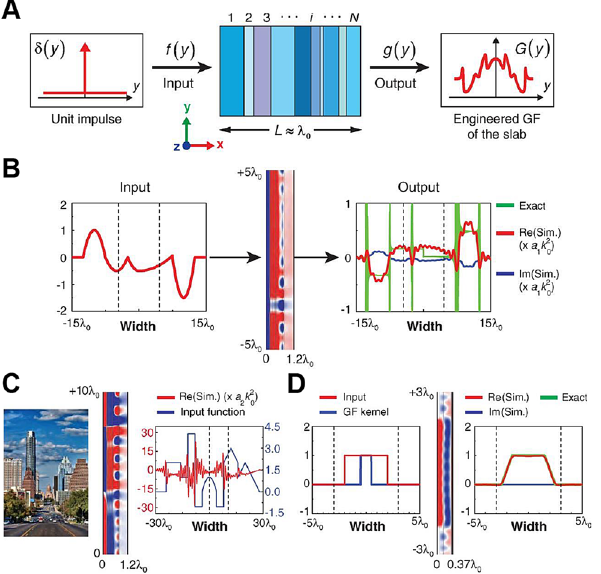
Figure9: Spatialanalogcomputingusingmetamaterialslabsbased on Green ’ s function approach [34].